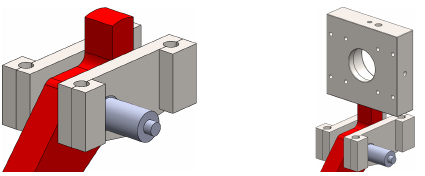
Figure 6: Axial load setup.